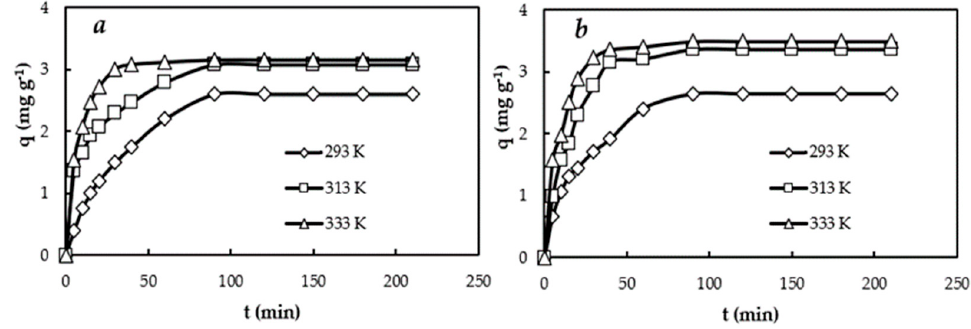
Figure 2. Kinetic adsorption curves of MB ( a ) and MG ( b ) on CS-C at different temperatures. In addition, the adsorption equilibrium of the cationic dyes on CS-C at all temperatures tested was reached in about 90 min, which was faster than the other citric-modified lignocellulosic materials. For example, Gong et al. [10,13] found that the adsorption equi- librium time for the removal of methylene blue on citric acid-modified rice straw was crystal violet on citric acid-modified wheat straw was about 300